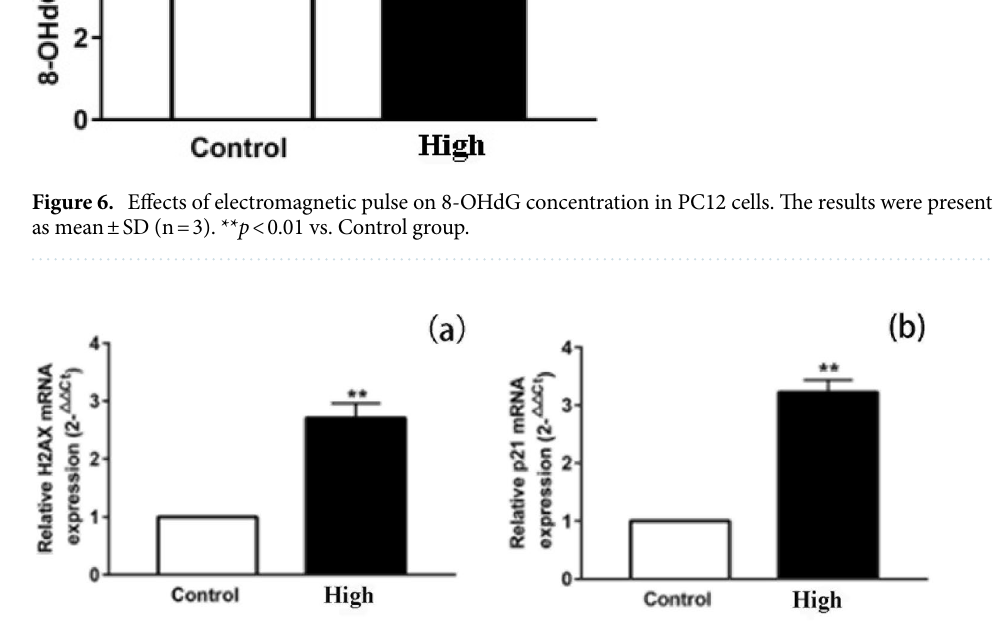
Figure 7. Effect of the mRNA expressions of H2AX and p21 in PC12. The mRNA levels of H2AX and p21were detected by Q-PCR. The mRNA levels of H2AX and p21were normalized to control. The results were presented as mean ± SD (n = 3). ** p < 0.01 vs. Control